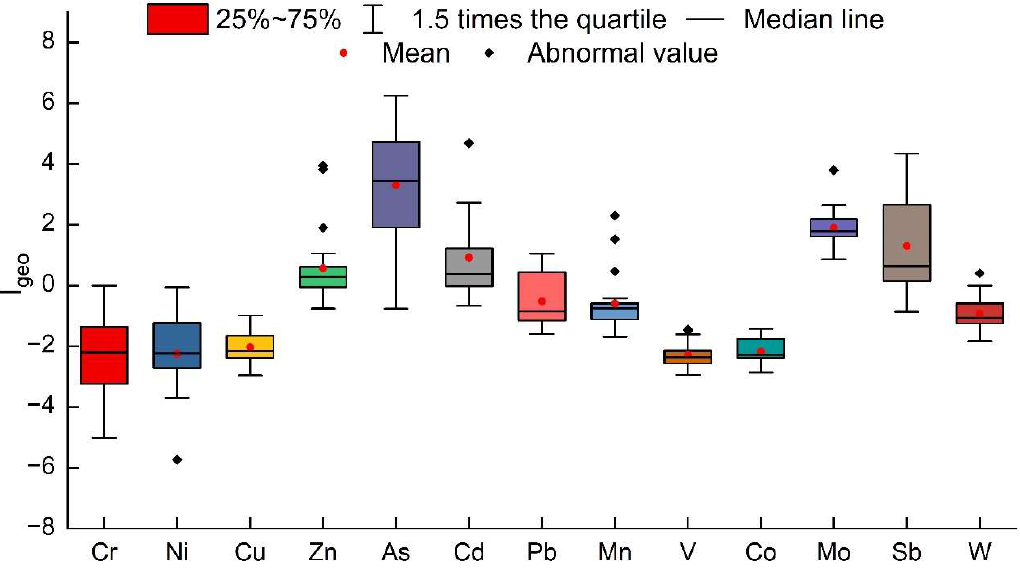
Figure 3. Boxplot of heavy metal geological accumulation index (Igeo) in surface sediments of the Feiyun River Basin. Table 3. Geological accumulation index method and potential ecological risk assessment